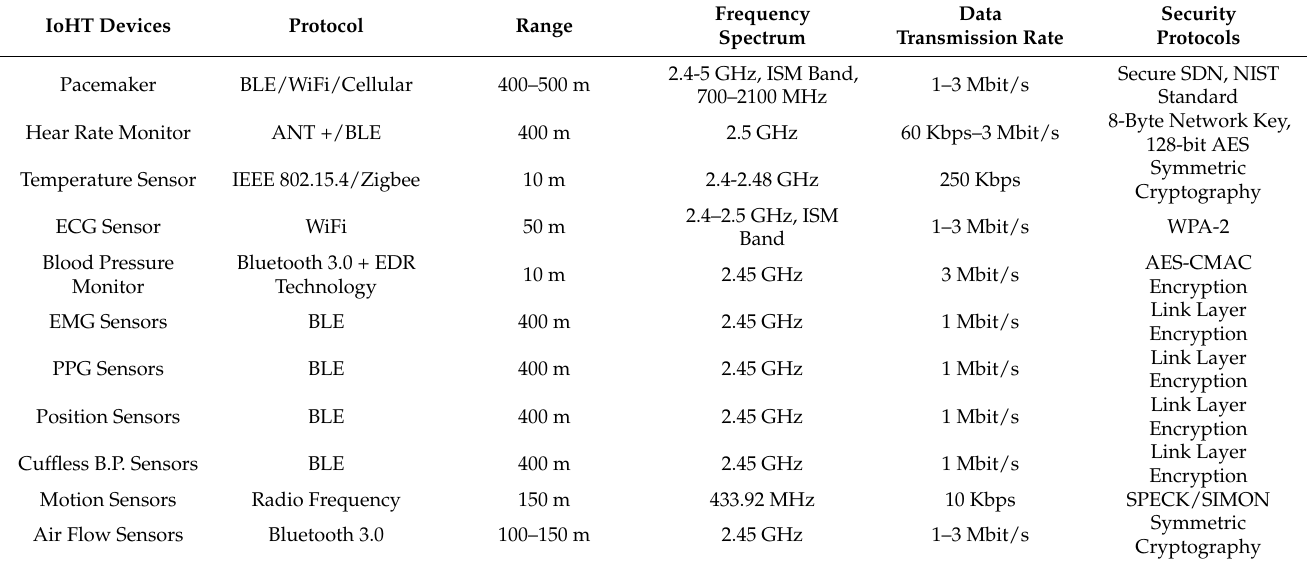
Table 2. IoHT Devices Technical